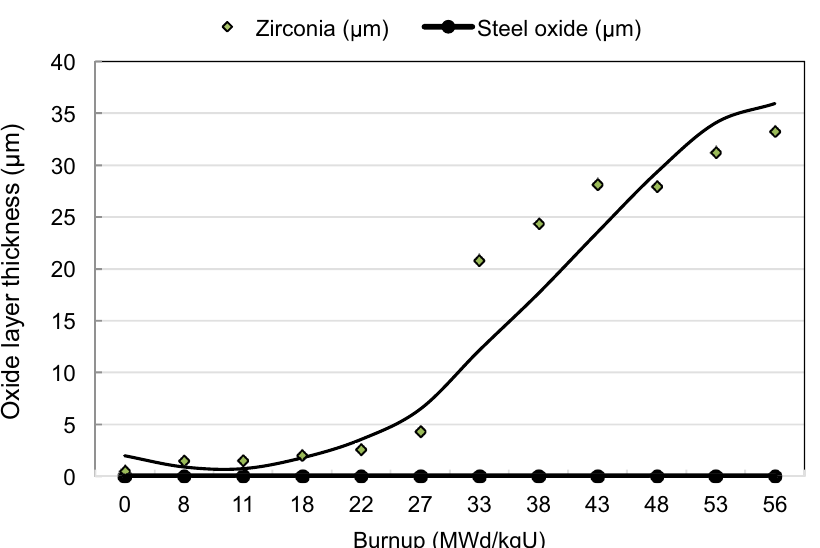
Fig. 3. Oxide layer thickness as a function of burnup for SS and Zy-4 simulated using IPEN-CNEN/SS and FRAPCON codes,